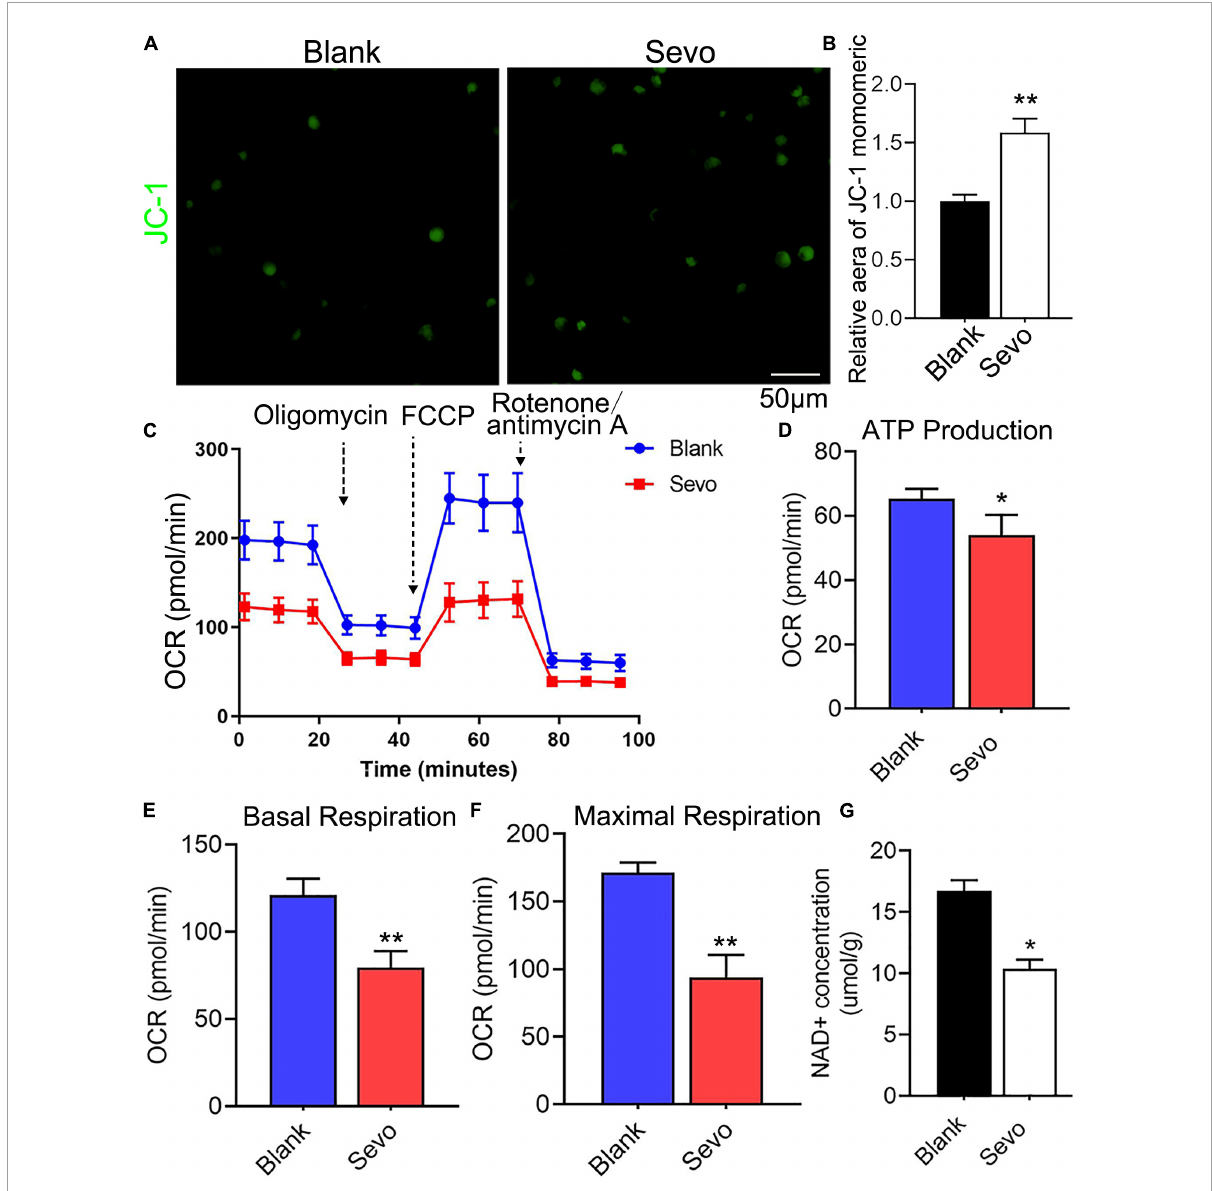
FIGURE4 Sevoflurane led to mitochondrial dysfunction. (A,B) Staining and quantitative analysis with JC-1 of BV-2 cell line. p = 0.0015. N = 3. (C) The overall mitochondrial metabolism using Seahorse experiment of BV-2 cell line. (D–F) The ATP production, basal respiration, and maximal respiration treated with mitochondrial stress kit agent including oligomycin, FCCP, and rotenone/antimycin A. p(ATP production) = 0.022, p(Basal respiration) = 0.001, p(Maximal respiration) = 0.0013. N = 4. (G) NAD + concentration was detected by NAD + production detection kit. p = 0.016. N = 3. Scale bar, 50 µ m. * P ≤ 0.05, ** P ≤